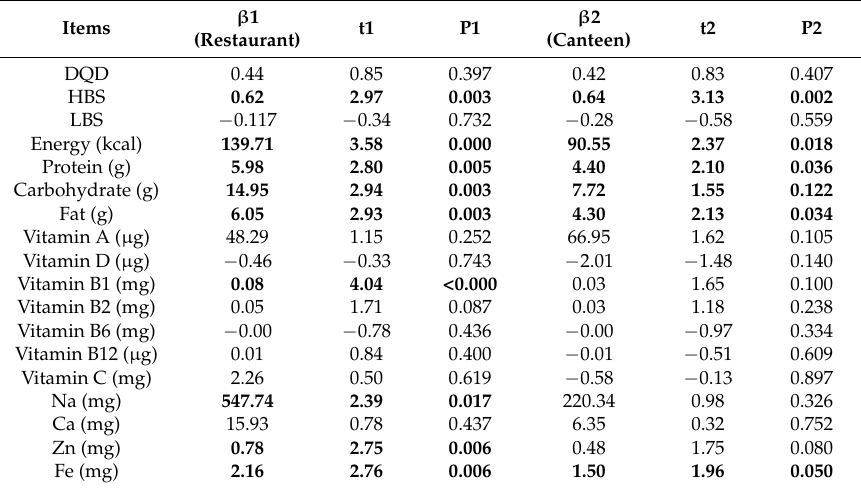
Table 3. Energy and nutrients between people eating outside or at